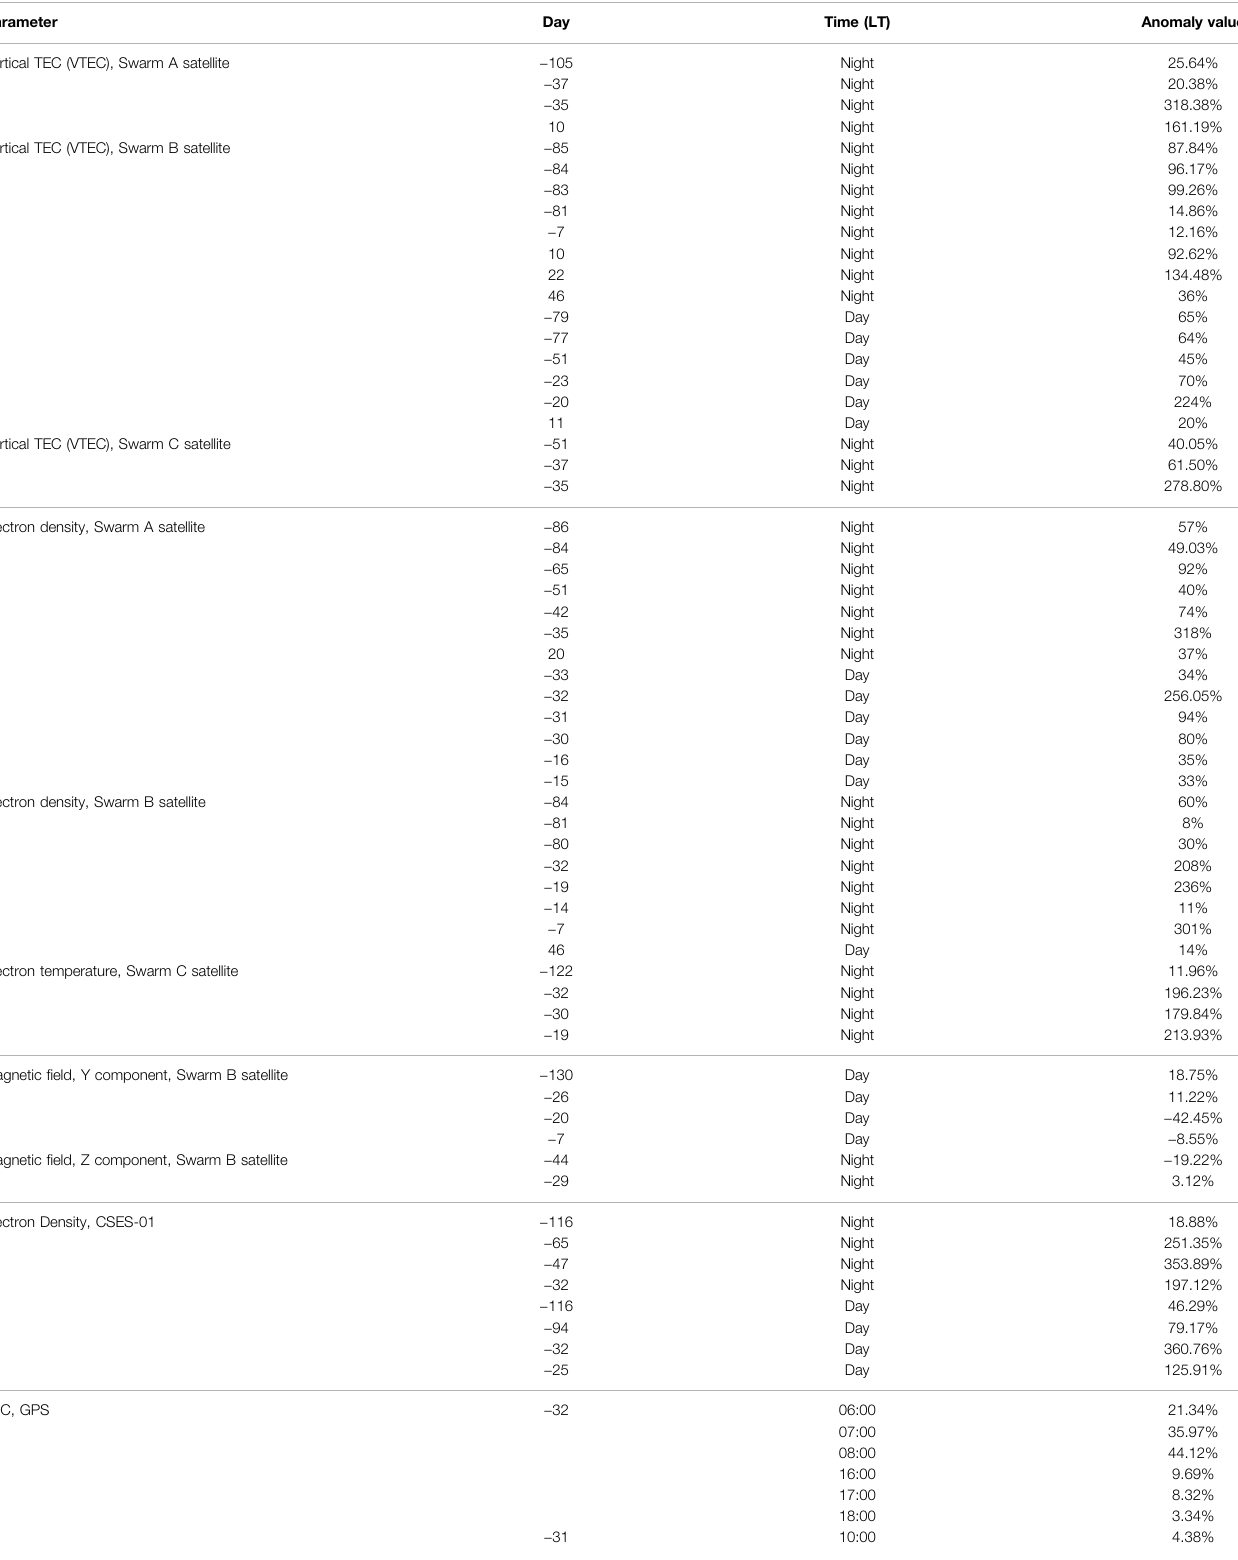
TABLE 1| Asummaryofthedetected anomaliesintheinvestigatedperiod.Theanomaliesaresortedfollowingthesecriteria:satellitethatdetects, nightandday,beforeand after the earthquake occurrence, and fi nally, in chronological order. The anomalies detected during high magnetic or solar activity are not listed. Also, TEC and Ne negative anomalies are not